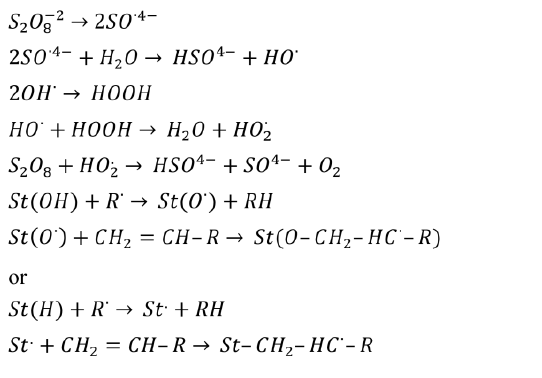
Figure 10. Mechanism of vinyl monomer “grafting from” starch by persulfate initiation. Adapted from [15].